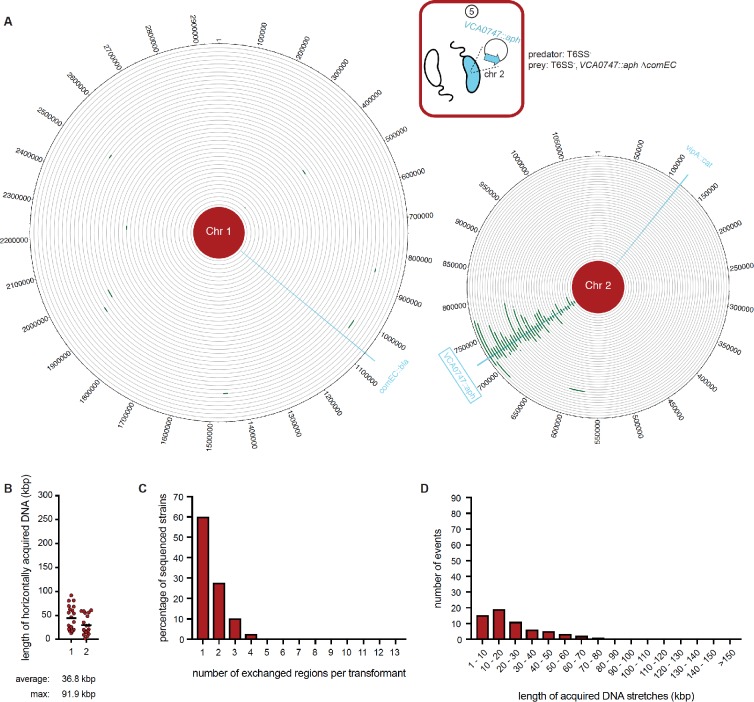
WGS-based quantification of horizontally acquired DNA under condition ⑤.Details as described for Figure 3 with the addition of the map of both chromosomes in panel A.